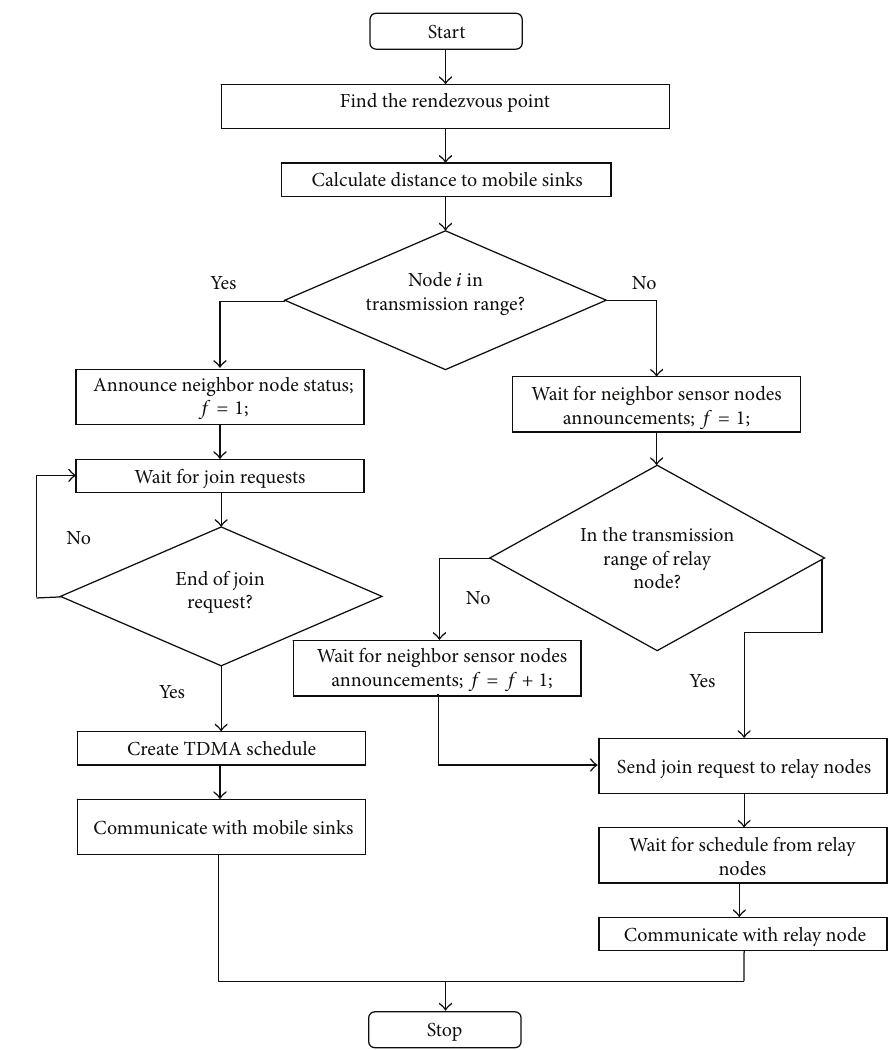
Figure 2: Flowchart of the proposed routing protocol.